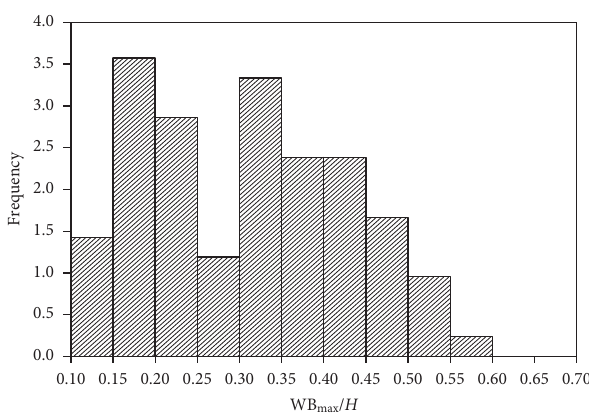
Figure 12: Frequency histogram of the maximum influence width coefficient along the Z